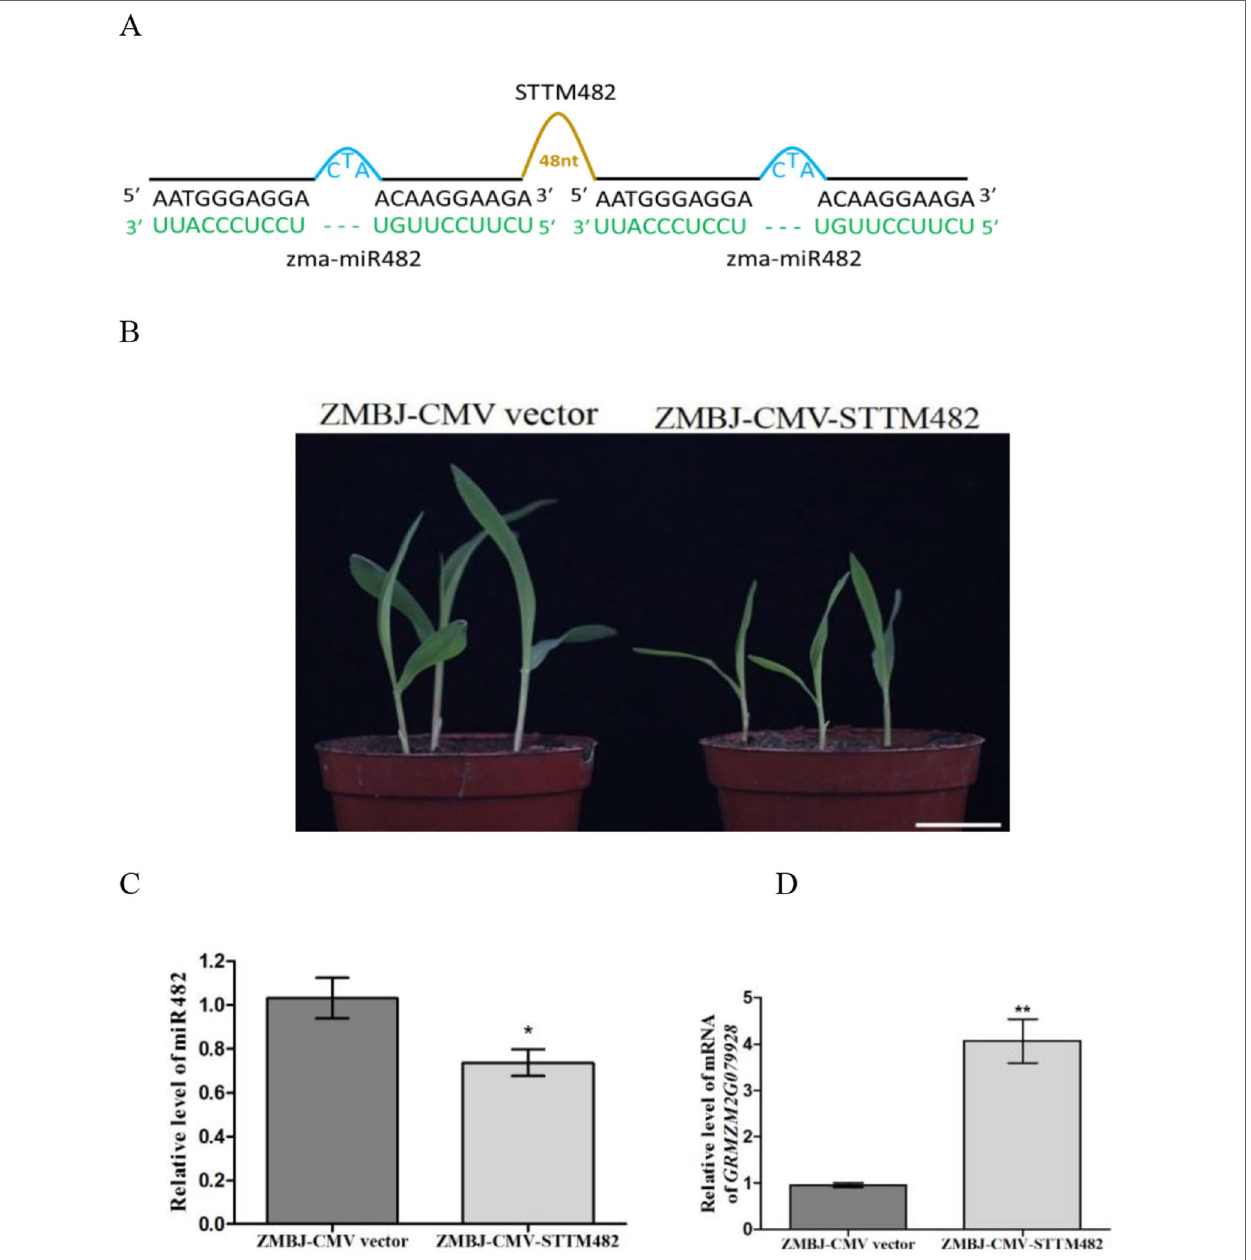
FIGURE 5 | Silencing miR482 expression in maize using ZMBJ-CMV-STTM482. (A) a diagram of the STTM482 insert in the ZMBJ-CMV-based VbMS vector. 48 nt, 48-nt long stem-loop like linker; —, no nt at this position. (B) Maize seedlings infected with ZMBJ-CMV (control) or ZMBJ-CMV-STTM482 were photographed at 14 dpi. Bars = 2 cm. (C) Relative expression of miR482 in maize was determined by stem-loop RT-qPCR. (D) Relative expression of miR482 target gene GRMZM2G079928 in the ZMBJ-CMV or ZMBJ-CMV-STTM482-infected plants. The first true leaves of the assayed seedlings were harvested at 14 dpi and used for this study. The results were analyzed and presented as described in Figure 2 . *, p < 0.05; **, p <